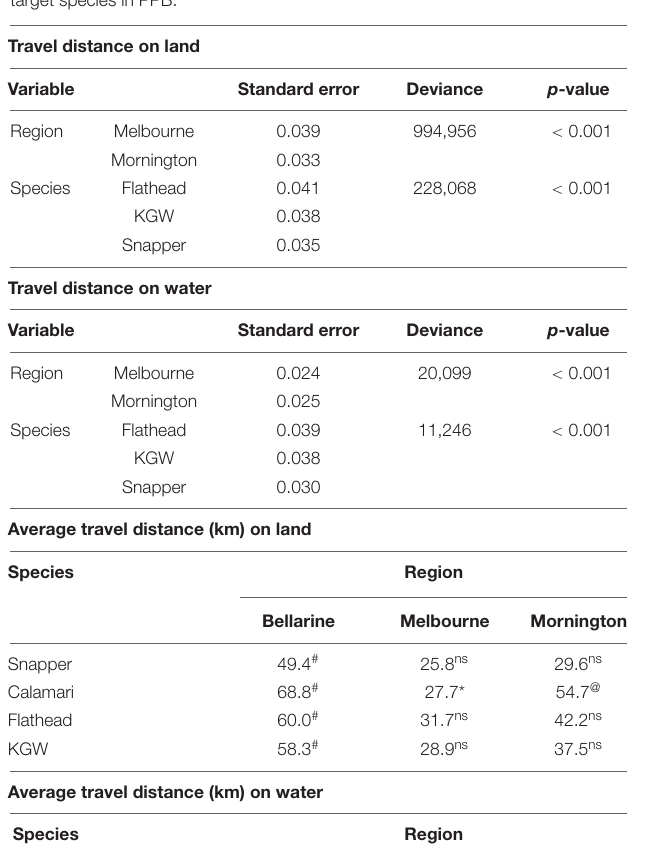
FIGURE 6 | Regional patterns (Bellarine, Melbourne and Mornington) in angler travel distance on land and water pooled among species and years. Each dot indicates an angler